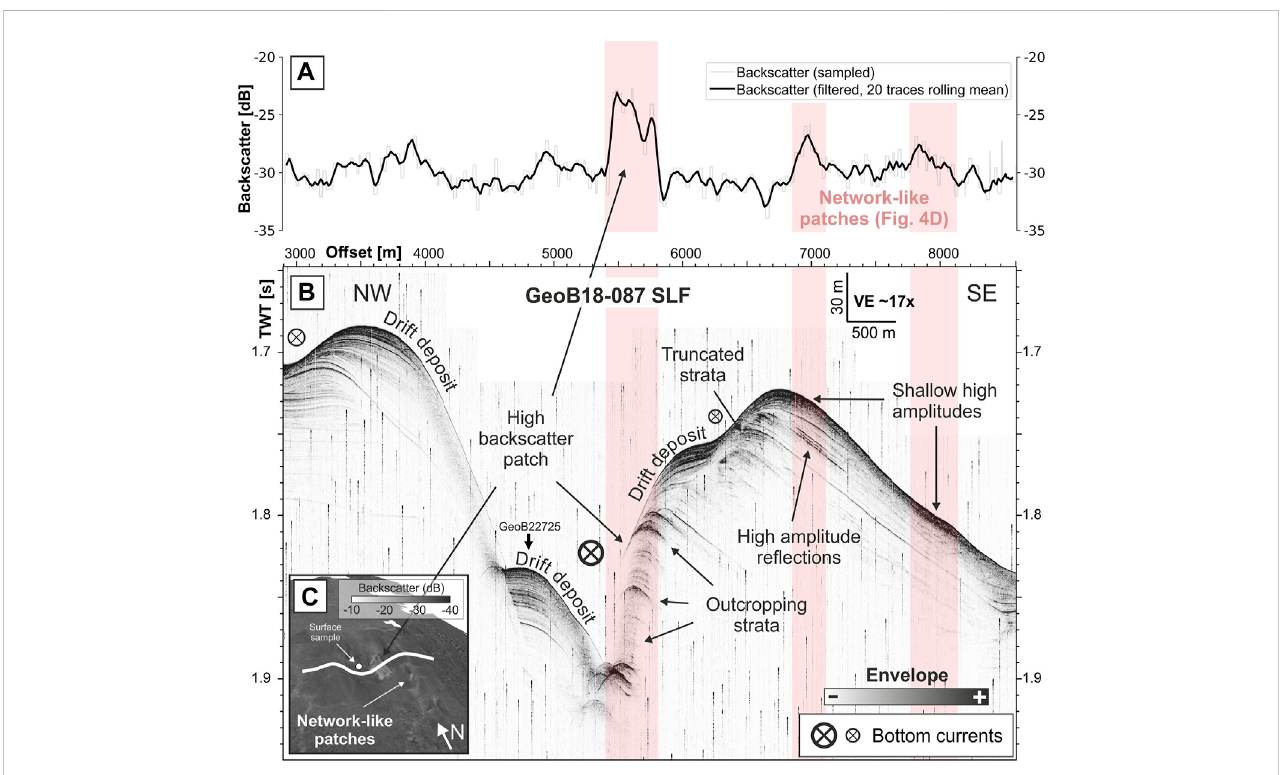
FIGURE 6 (A) Sampled (light grey line) and smoothed (black) backscatter intensities from a mosaic (25 m resolution) along (B) PARASOUND pro fi le GeoB18-087 (4 kHzSLFenvelope)crossingSD-S.Areasofhighbackscattervaluesmarkedwithlightredrectanglescorrelatewithhighamplitudere fl ectionsintheacoustic pro fi le. (C) PerspectiveviewofSD-SfromSWshowingthespatialextentofhighbackscatterpatchinsideSD-S(whitecolors)andlocationofpro fi le(thickwhite line). For the exact location of the pro fi le, refer to Figure